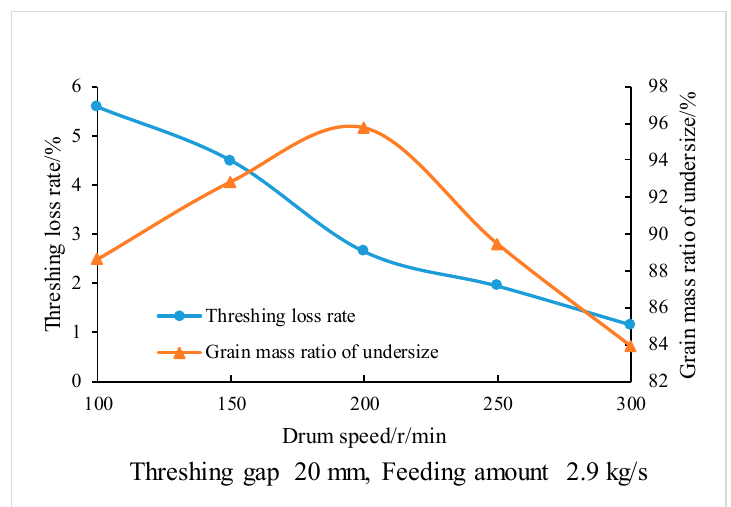
Figure 9. Effect of drum speed on threshing performance.